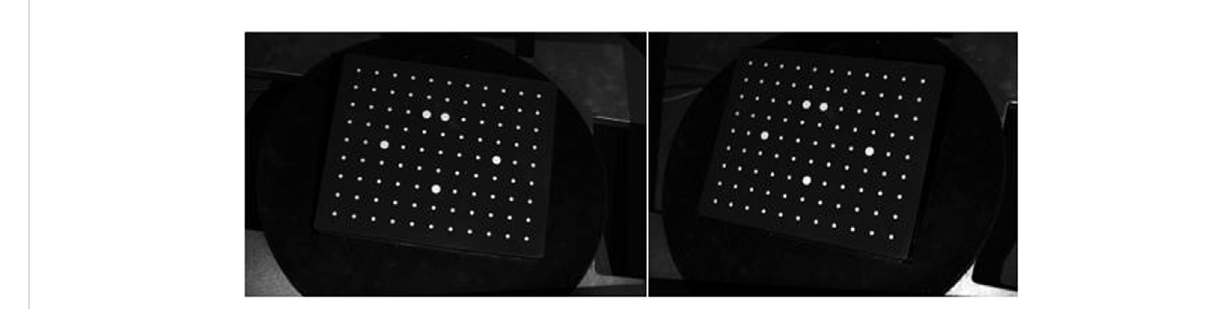
FIGURE 6 Target image acquired by the binocular vision